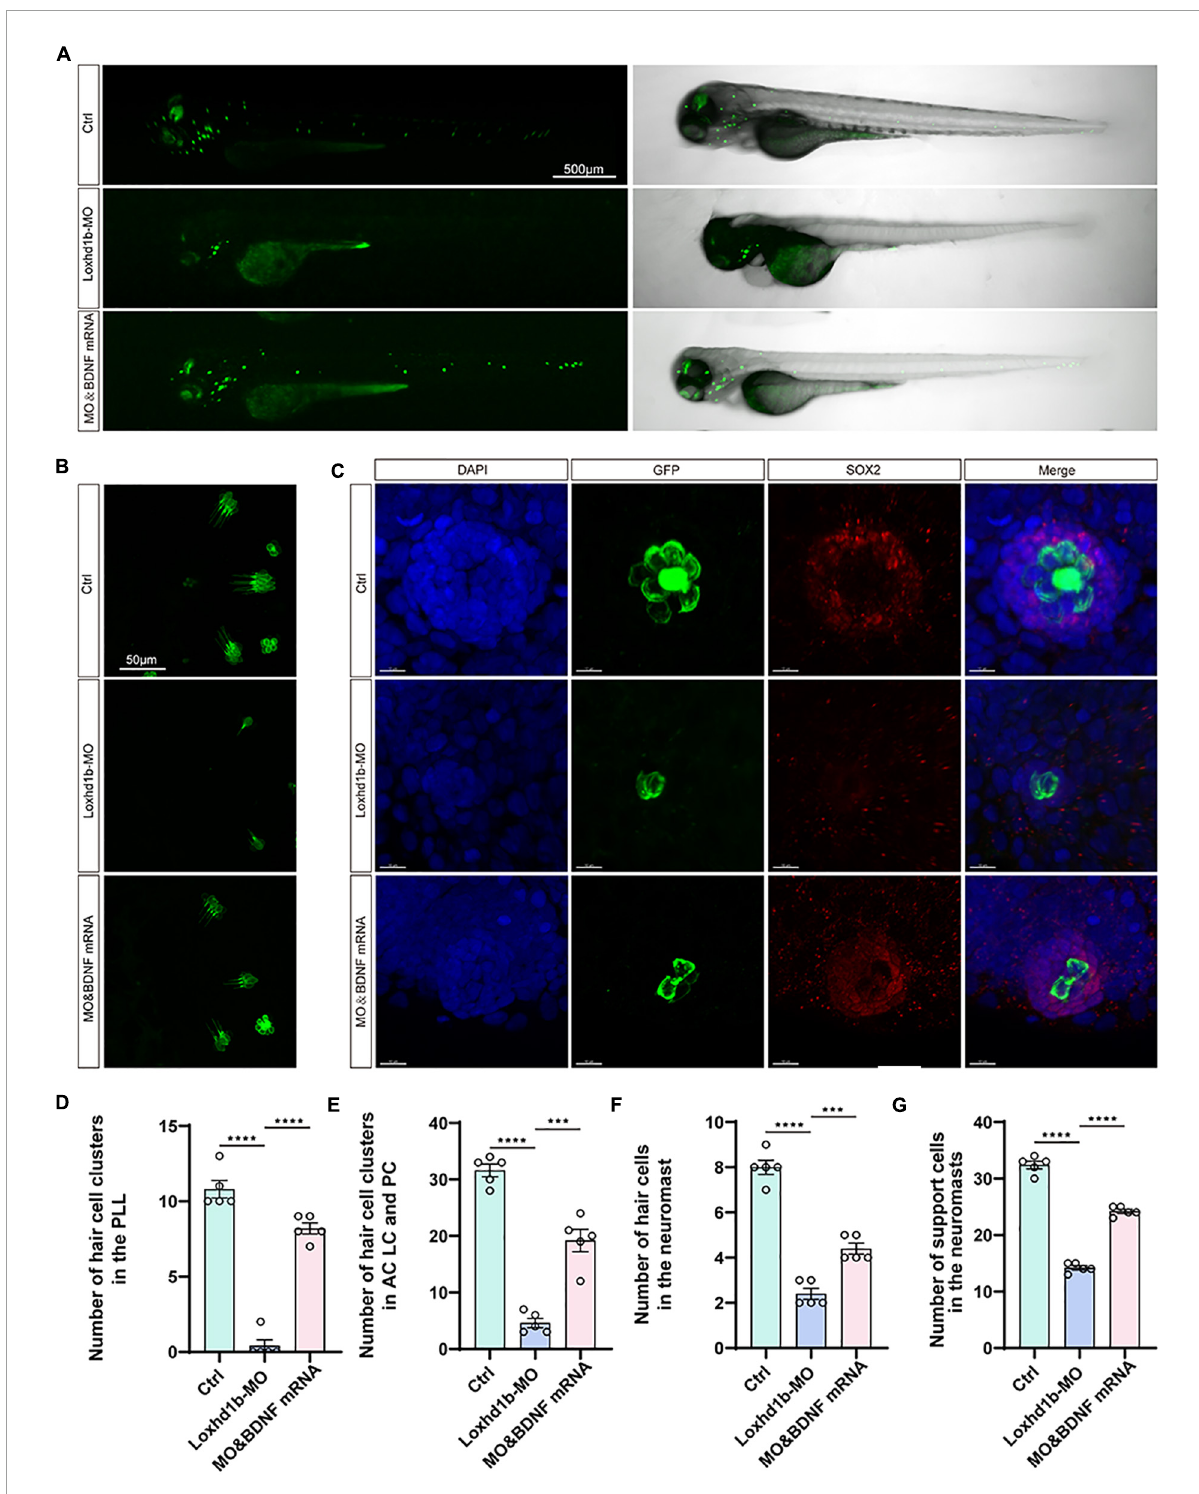
FIGURE8 The developmental defects of hair cells in Loxhd1b morphants rescued by BDNF mRNA. (A) Imaging analysis of control, Loxhd1b morphants, and rescued zebrafish at 72 hpf in bright field (right) and fluorescent field (left). Scale bar = 500 µ m. (B) Imaging analysis of cristae hair cells in control, Loxhd1b morphants, and rescue group at 72 hpf. Scale bar = 50 µ m. (C) Imaging analysis of support cells in control, Loxhd1b morphants, and rescue group at 72 hpf. Scale bar = 50 µ m. (D) Quantification of the number of hair cell clusters in the posterior lateral line of different groups at 72 hpf. (E–G) Statistical analysis of the number of different hair cells and support cells in different groups at 72 hpf. *** P < 0.001 and **** P <